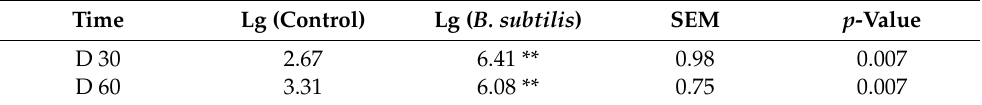
Table 3. The capability of colonization of Bacillus subtilis expressed in feces.